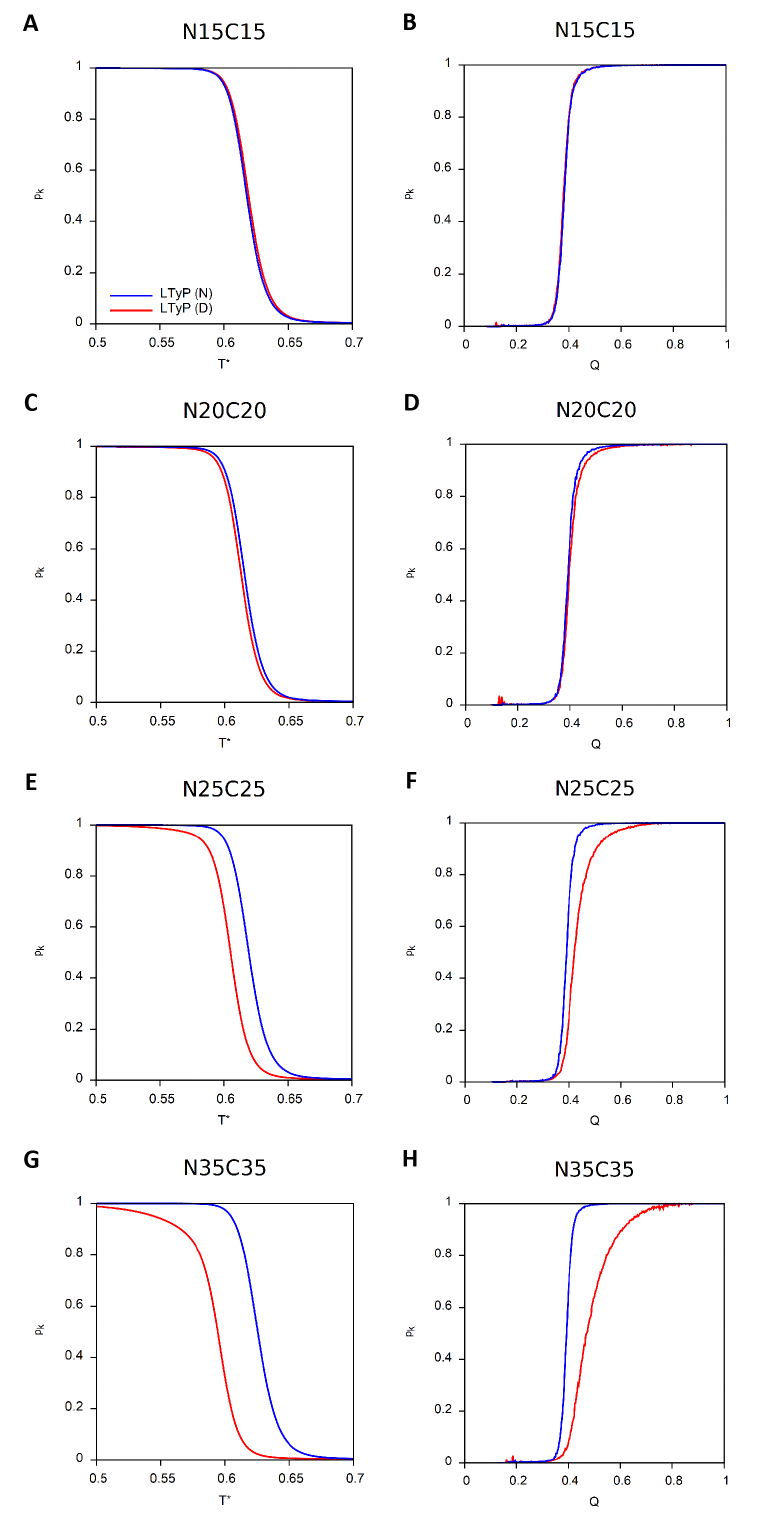
Figure 7. Knotting probability, p k , as function of reduced temperature and of Q for MJ0366 with tails of increasing length. Simulations starting from native conformation (N) are colored blue and those starting from a denatured conformation (D) are colored red. ( A , B ) N15C15. ( C , D ) N20C20. ( E , F ) N25C25. ( G , H )